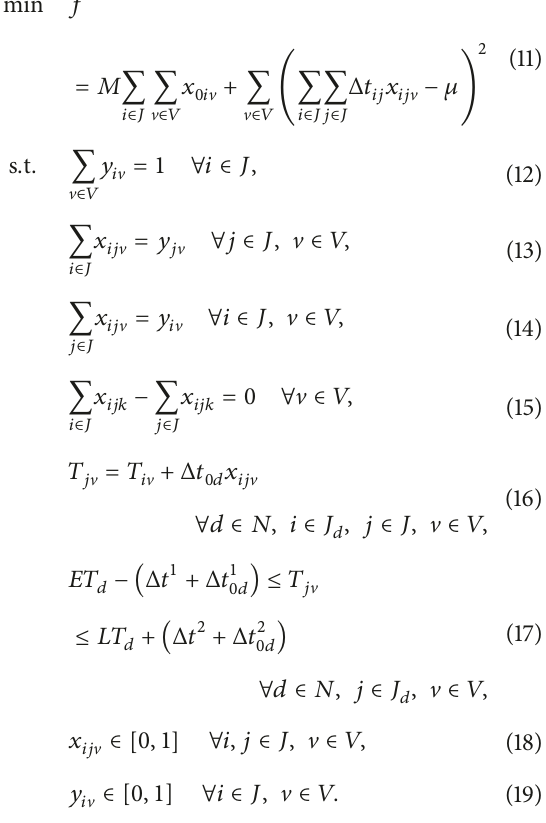
indicate whether assignment 𝑖 is implemented by vehicle V